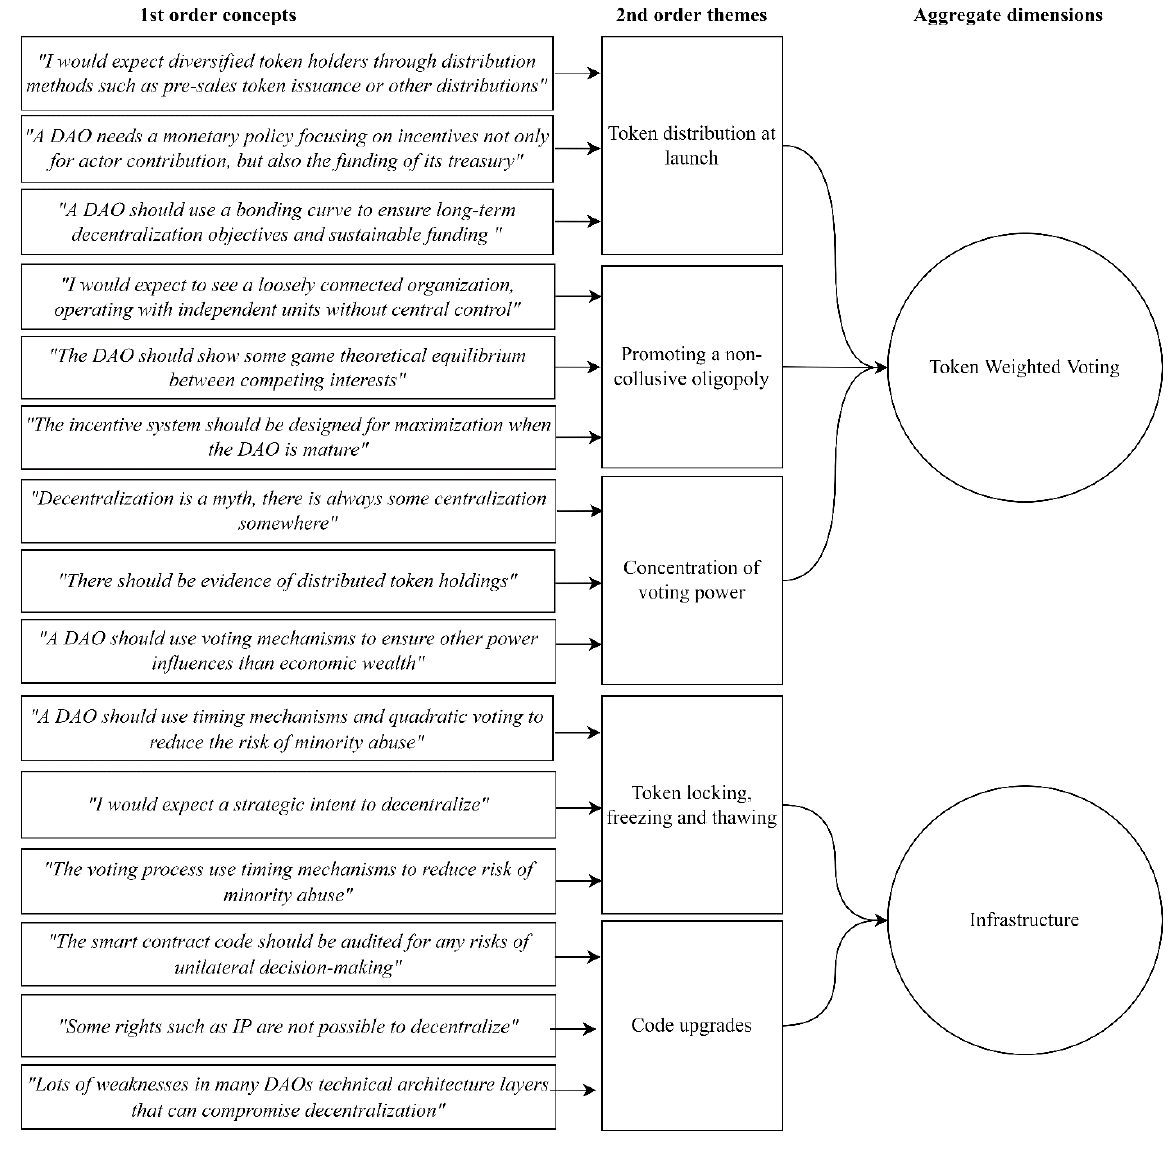
Figure 3a. Coding of data to themes (1 of